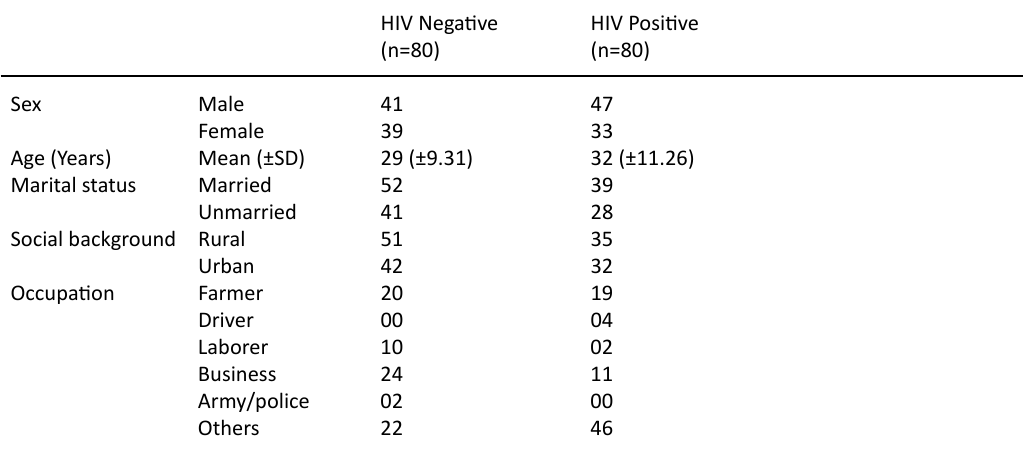
Table 1. Demographic Profile of Study Groups